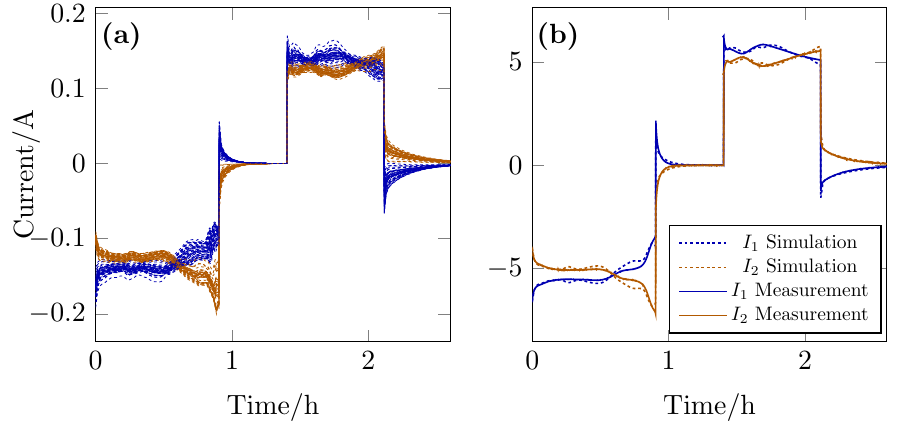
Figure 8. Comparison of measurement and simulation, with the simulated cell layer currents I i ,1 and I i ,2 , i (cid:101) { 1, . . . ,40 } within cell one and two in ( a ) and the simulated cell currents as well as the measurement results of cable type 1 in ( b